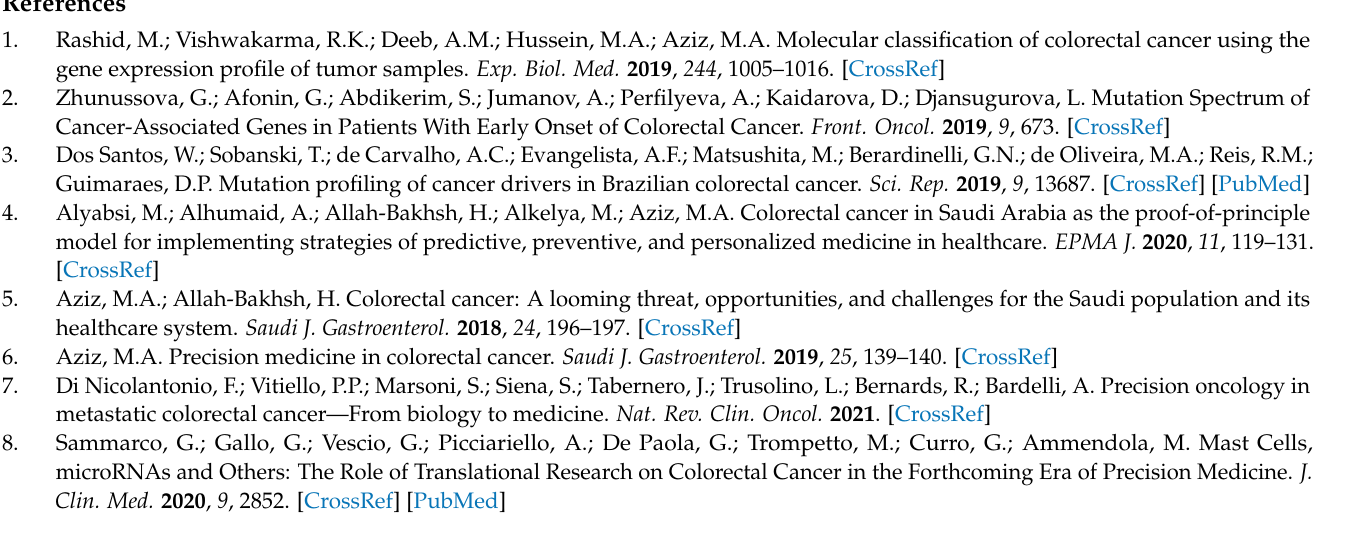
this study. Table S2: Details of reported novel variants. Table S3: VAF of reported novel variants Table S4: novel variants in colorectal cancer. Table S5: Target molecules in reported pathogenic mutations in the large